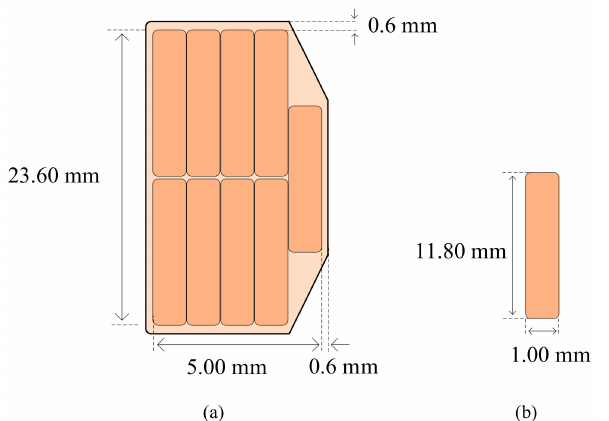
Figure 5. ( a ) The dimension and the arrangement of one turn, and ( b ) the dimension of one conductor for HV winding.